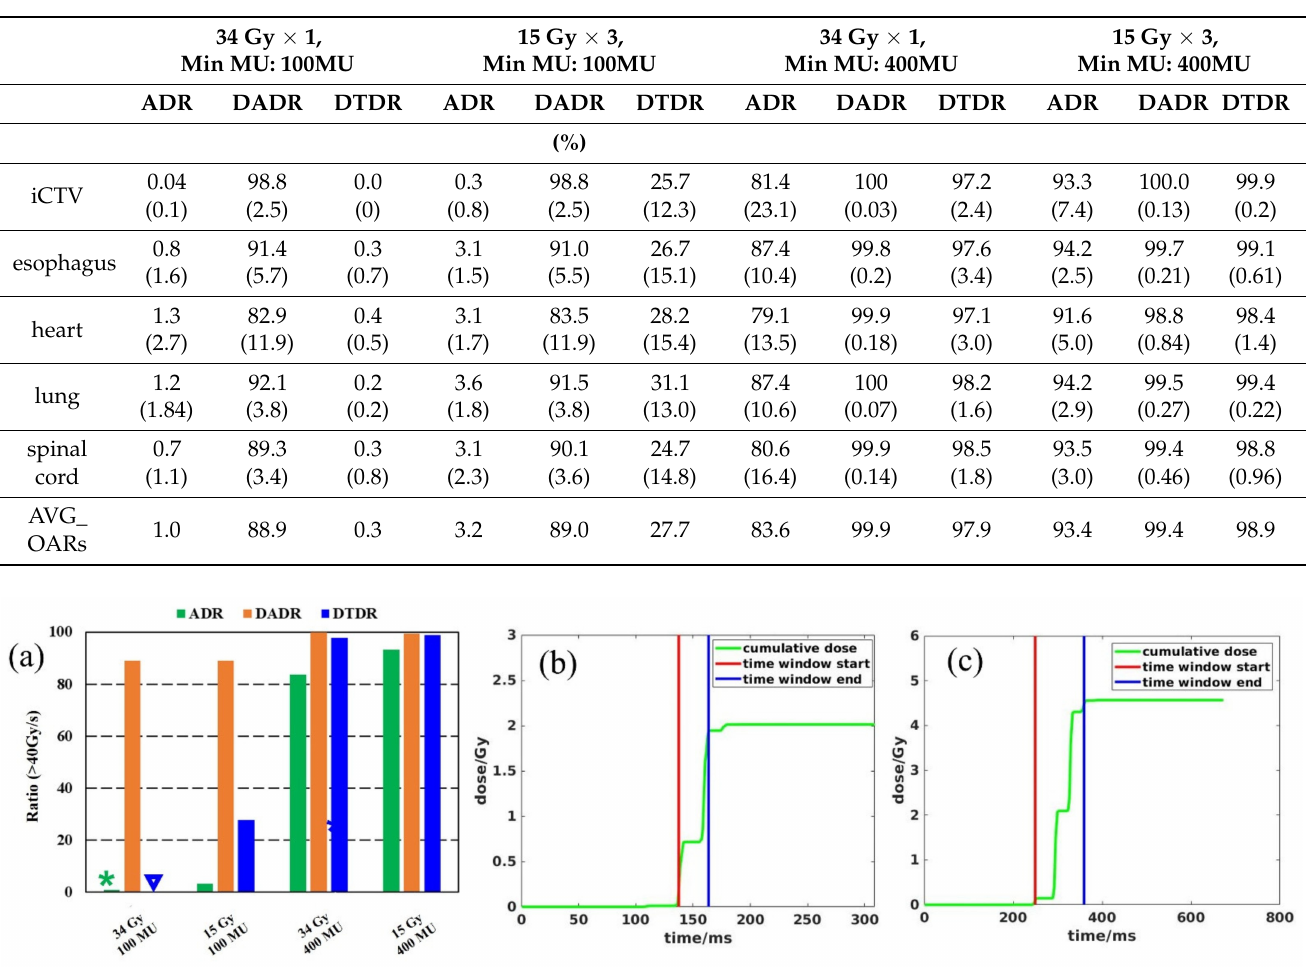
Table 2. V 40Gy/s statistics for iCTV and OARs among ADR, DADR, and DTDR methods. The ratios are calculated by averaging the plans for all nine patients under each of the three dose rate methods, and the standard deviation is expressed in the parentheses. The last row of the table shows the averaged dose rate for the five OARs under each of the three dose rate methods for illustration purposes.